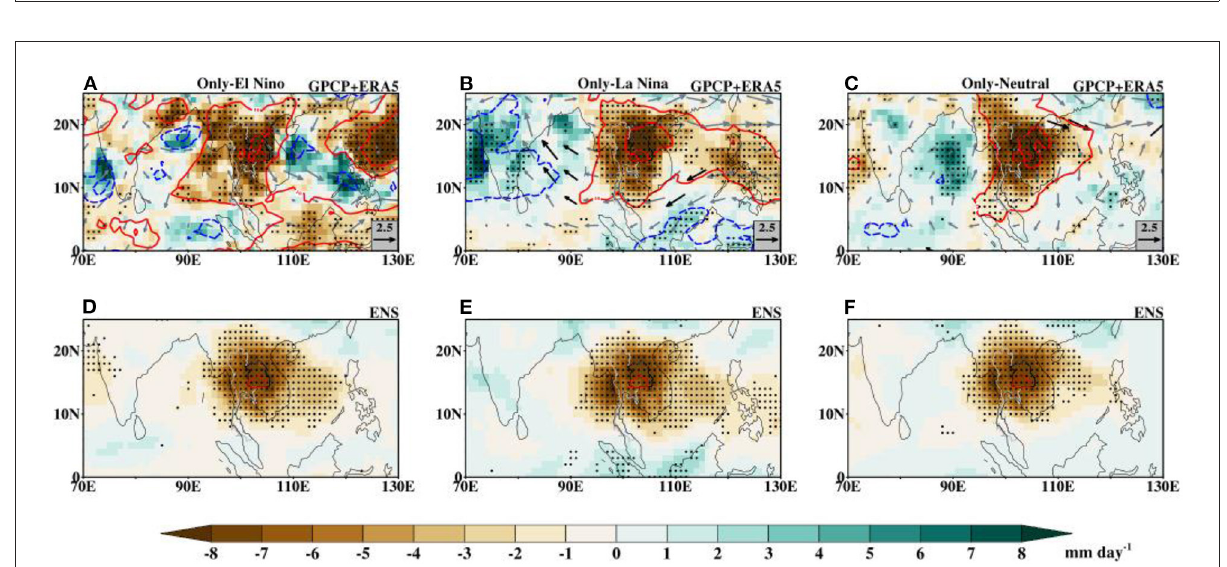
FIGURE8 (A–F) Dry spells composite anomalies of observed rainfall (shaded), OLR (contours), and wind fields at 850mb level (vectors) for ENSO phases and inactive BSISO for the May–October season during the period 1997–2014. The dotted areas signify statistically significant rainfall composites. The black arrows are statistically significant at the 95% level while the slategrey arrows are not. The bottom three panels is the ensemble mean of simulated rainfall anomalies. The dotted areas show where at least 80% of the models agree on the sign of change of the ensemble